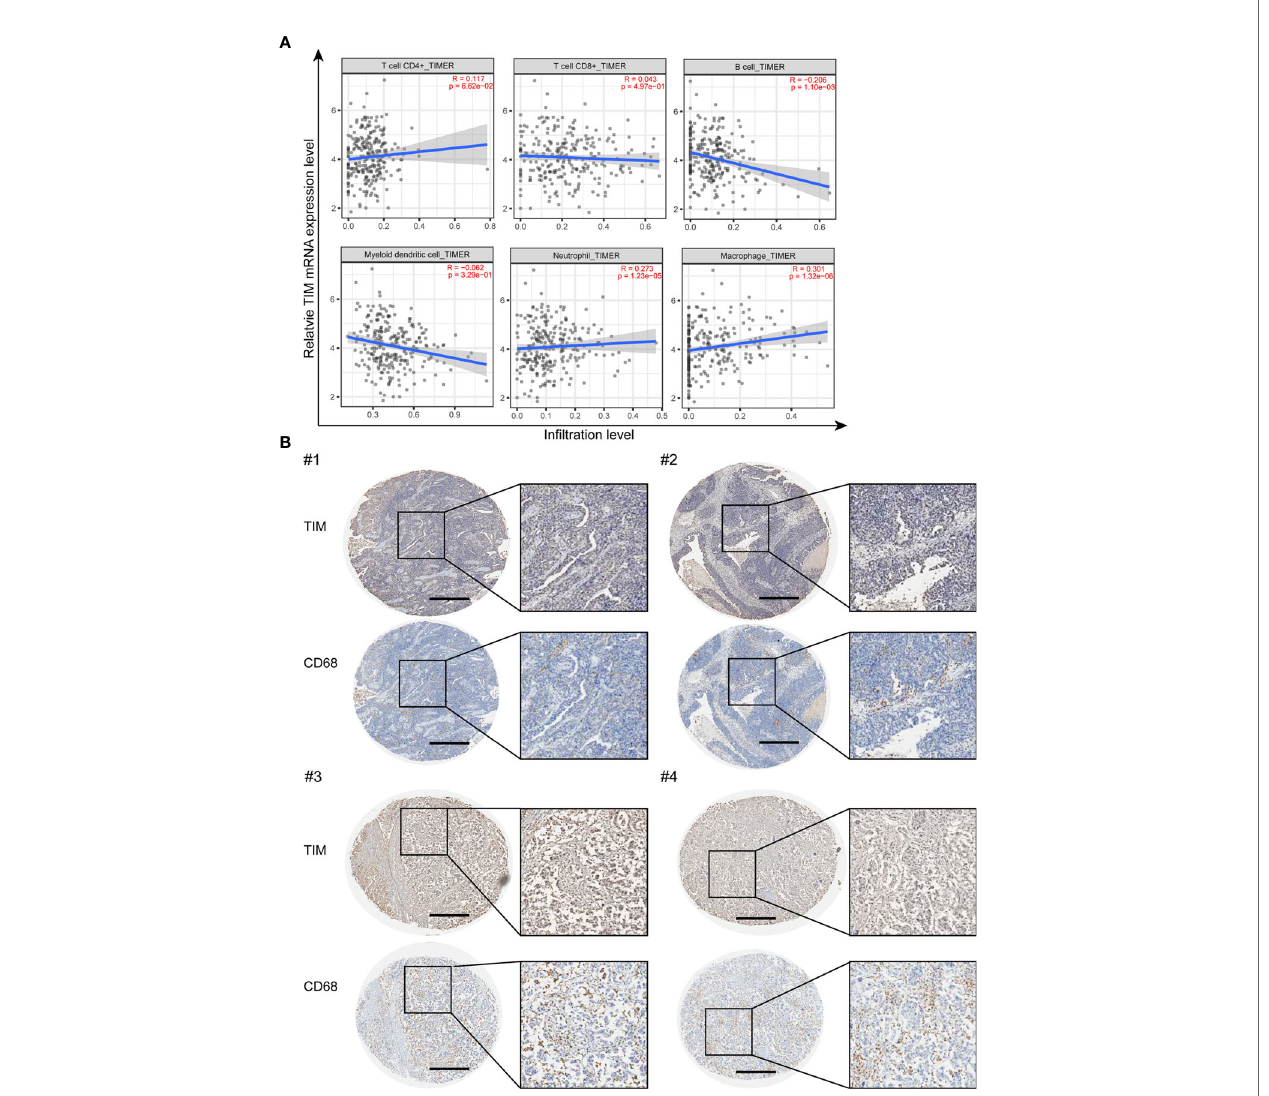
FIGURE 5 | The in fi ltration of macrophages was closely associated with TIM expression in human samples. (A) The correlation between TIM expression levels and the in fi ltration of different immune cell subsets were analyzed in OV by using TIMER. (B) IHC staining of TIM and macrophage marker CD68 in OV tissue samples. Scale bar = 500 m